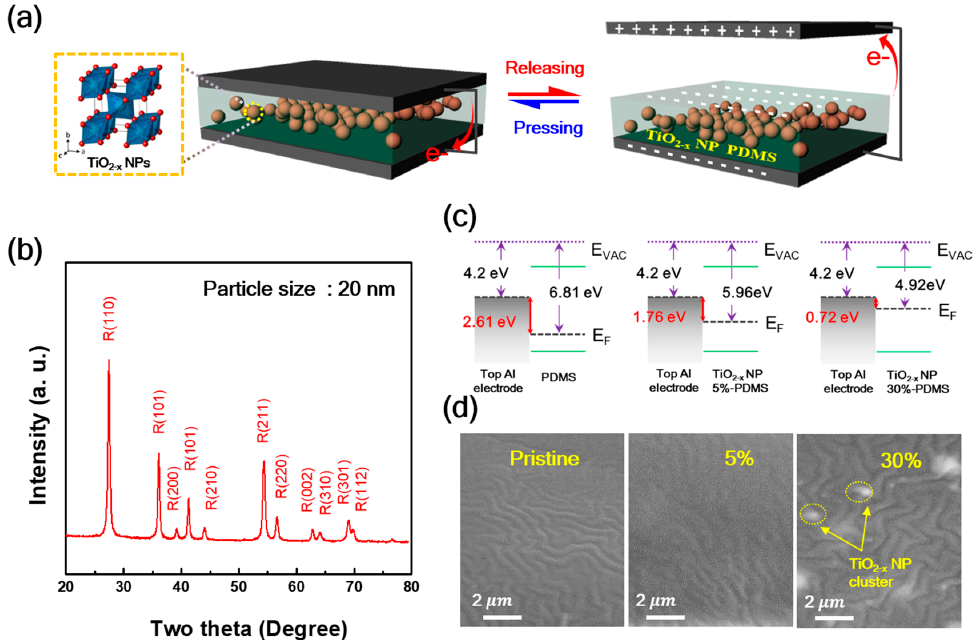
Figure 1. ( a ) Schematic of the vertical contact–separation mode triboelectric nanogenerators (TENG) with TiO 2 − x NPs embedded in polydimethylsiloxane (PDMS) as friction layers; alternating current is generated upon pressing and releasing; ( b ) X-ray diffraction (XRD) spectra of the TiO 2 − x nanoparticles (NPs); ( c ) The energy band diagram, and ( d ) Scanning electron microscope (SEM) image of PDMS as a function of the TiO 2 − x NPs embedded weight ratio.